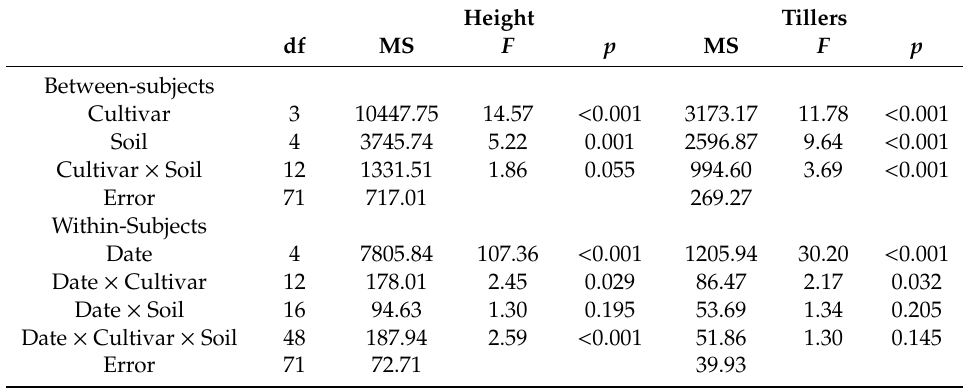
Table 3. Repeated measures ANOVAs for height and tillers as a function of cultivar (“Cultivar”), soil inoculum source (“Soil”), and date of measurement (“Date”). Greenhouse-Geisser corrected p values are reported for within-subjects e ff ects (height, epsilon = 0.630; tillers, epsilon =